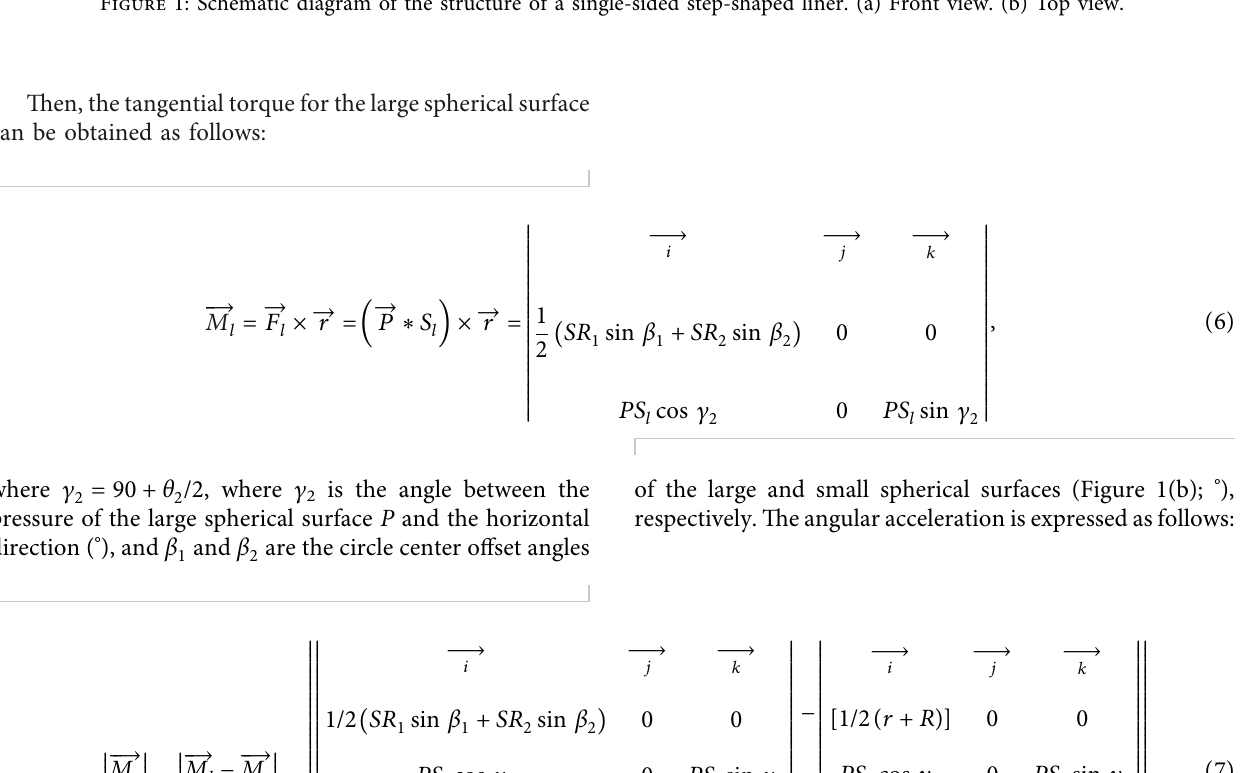
Figure 1: Schematic diagram of the structure of a single-sided step-shaped liner. (a) Front view. (b) Top